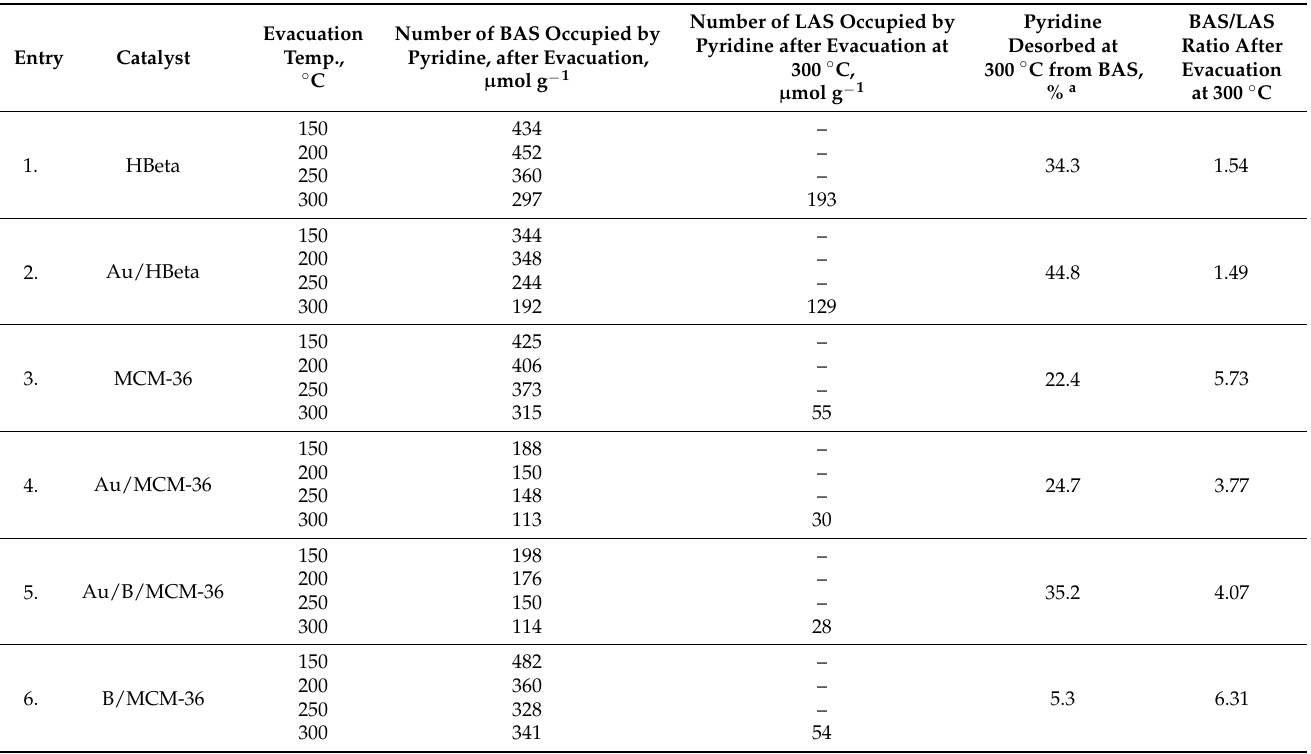
Table 2. Content of Brønsted (BAS) and Lewis (LAS) acid sites occupied by pyridine after desorption at different tempera- tures. The calculation based on intensity of IR bands (1545 cm − 1 for BAS and 1455 cm − 1 for LAS) and extinction coefficients of 0.044 cm 2 µ mol − 1 for BAS and 0.165 cm 2 µ mol − 1 for LAS from [23]. Evacuation Entry Catalyst